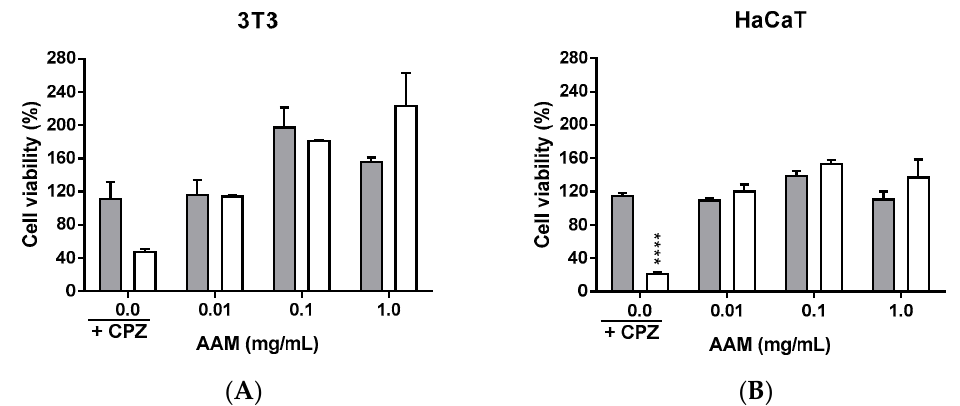
Figure 5. Phototoxicity activity of AAM in 3T3 ( A ) and HaCaT ( B ) cell lines obtained by MTT assay and expressed as percentage of cell viability respect to the correspondent control cells. Chlorpromazine cell viability was used as positive control. Gray columns correspond to non-exposed cells to UVA light and white columns correspond to cells exposed to 1.8 J/cm 2 of UVA light. Results are expressed as mean ± standard error of n = 3. A two-way analysis of variance (ANOVA) and a Bonferroni post hoc assay have been performed. Statistical differences were considered as follows: **** p ≤ 0.0001 in comparison with the equivalent non-irradiated condition homologue.